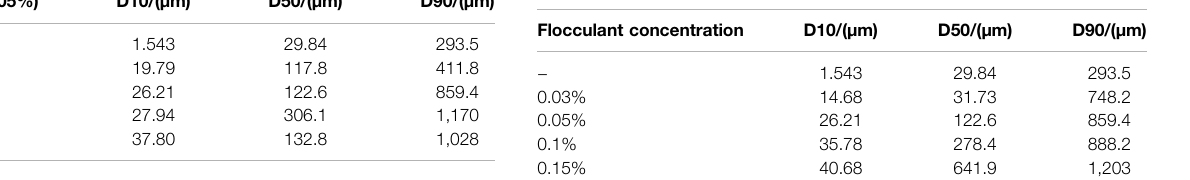
TABLE 12| EffectofSDYJ-2emulsionwithdifferentconcentrationonparticlesize distribution of PEM drilling fl uid. Flocculant concentration